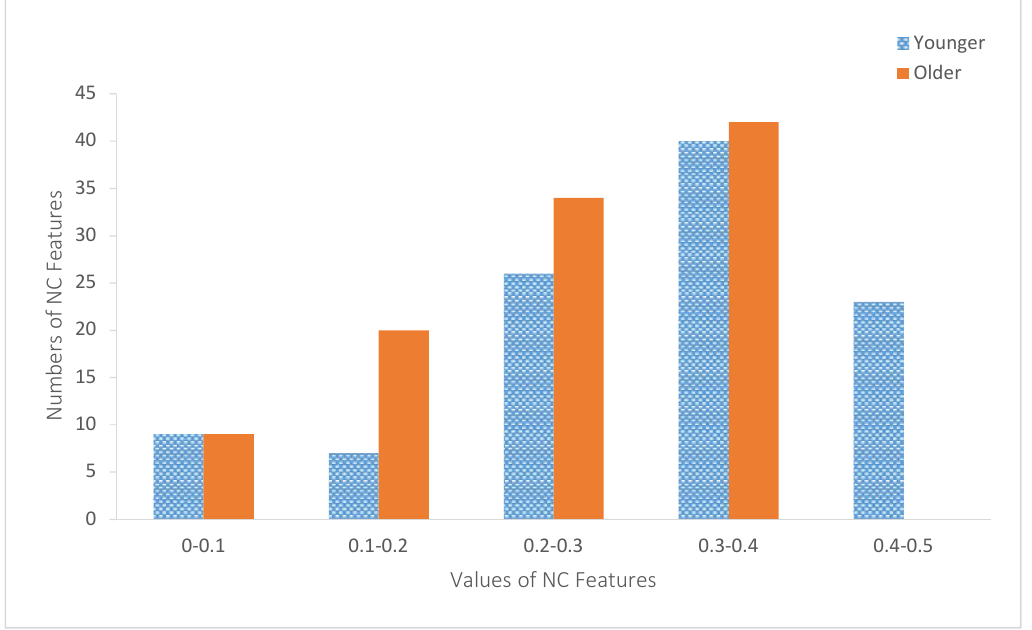
Figure 4. Histograms of the negative correlation (NC) features of both age groups.